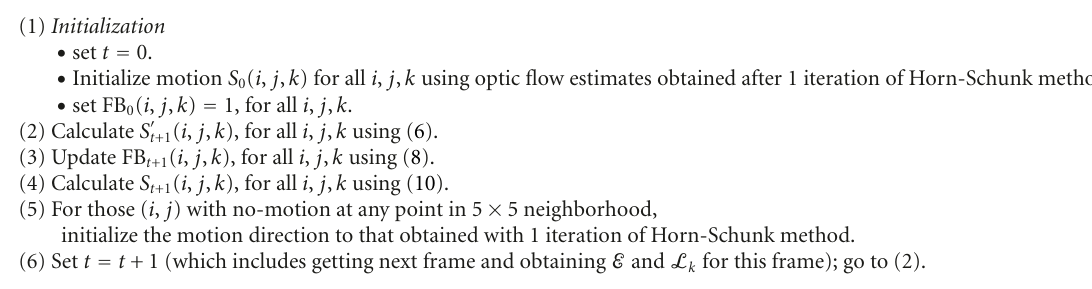
Algorithm 1: Complete pseudocode for motion direction